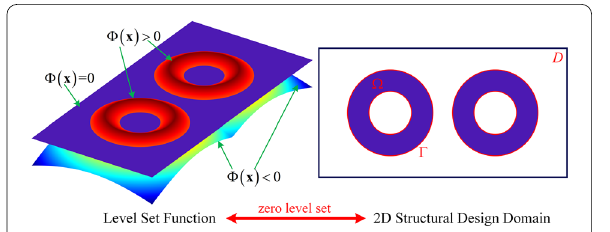
Figure 5 A 3D level set function and 2D design domain